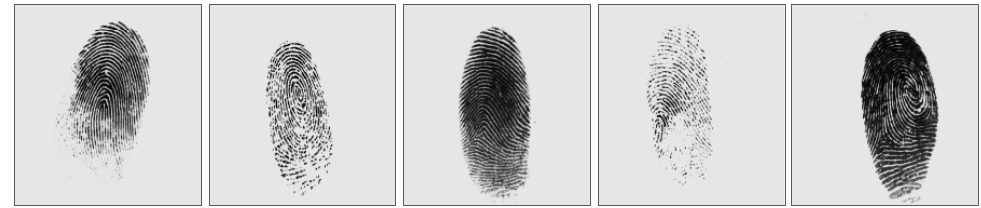
Figure 10. A sample of fingerprint images from the FVC2004 fingerprint